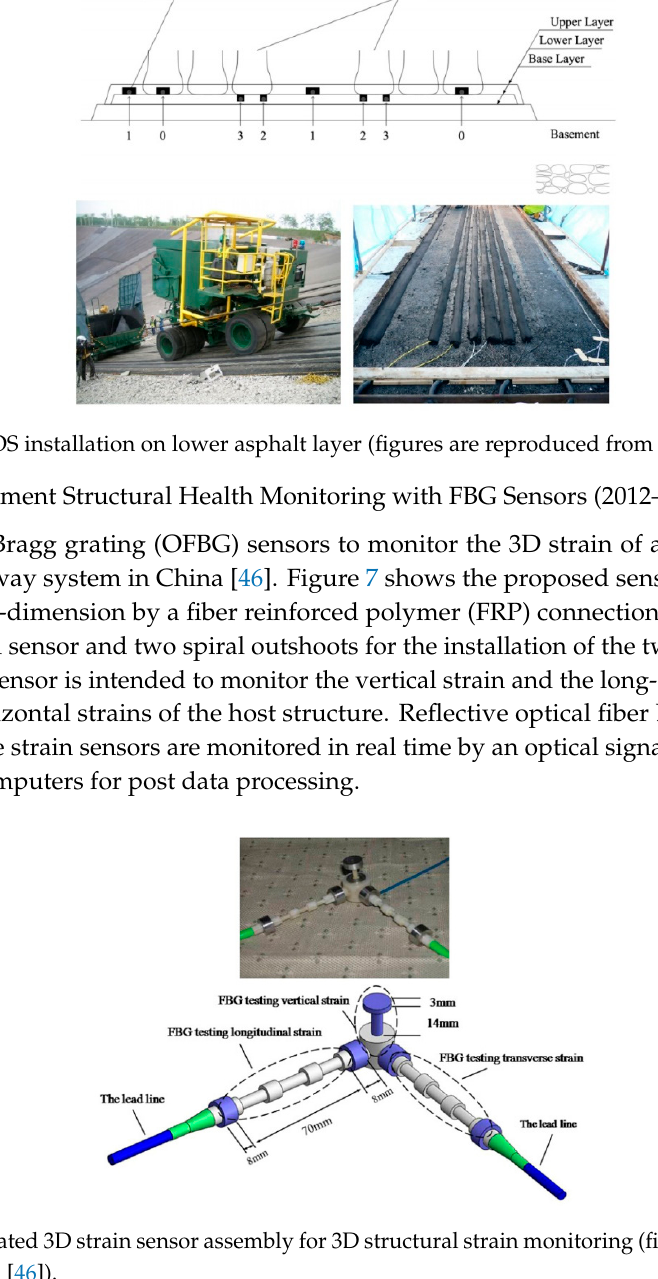
Figure 6. FOS installation on lower asphalt layer (figures are reproduced from Imai et al. [7]).